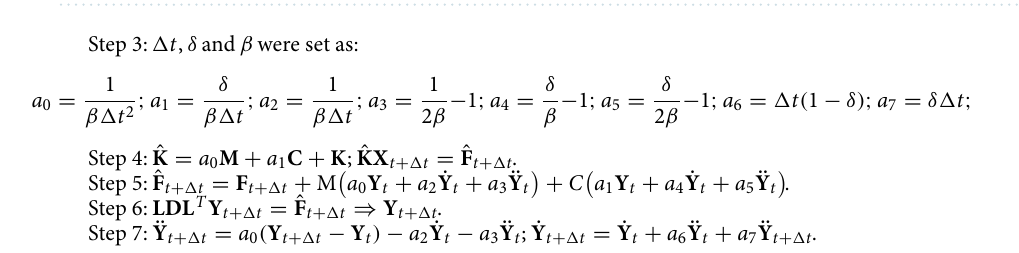
Figure 5. Vibration displacement (VD) and vibration swing angle (VSA) curves of the key parts of the shearer: ( a ) VSA of the front drum; ( b ) VD of front rocker arm; ( c ) VD of the front traction part; ( d ) VD of the front walking box; ( e ) VD of the front support part; ( f ) VD of the shearer